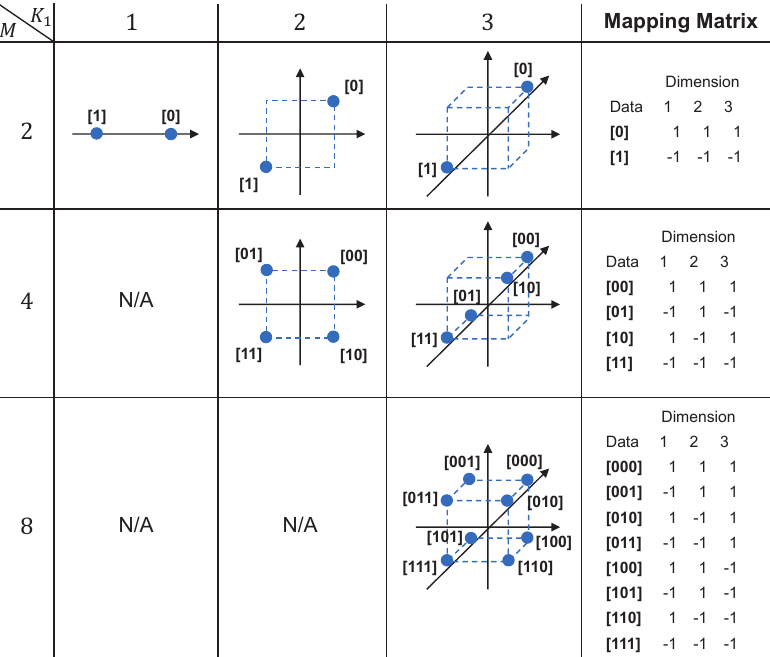
Figure 5. Example of the constellation mapping function with respect to M and K 1 for ˜ M = 2. ( (cid:126) b = [ 1, 1 ] T −